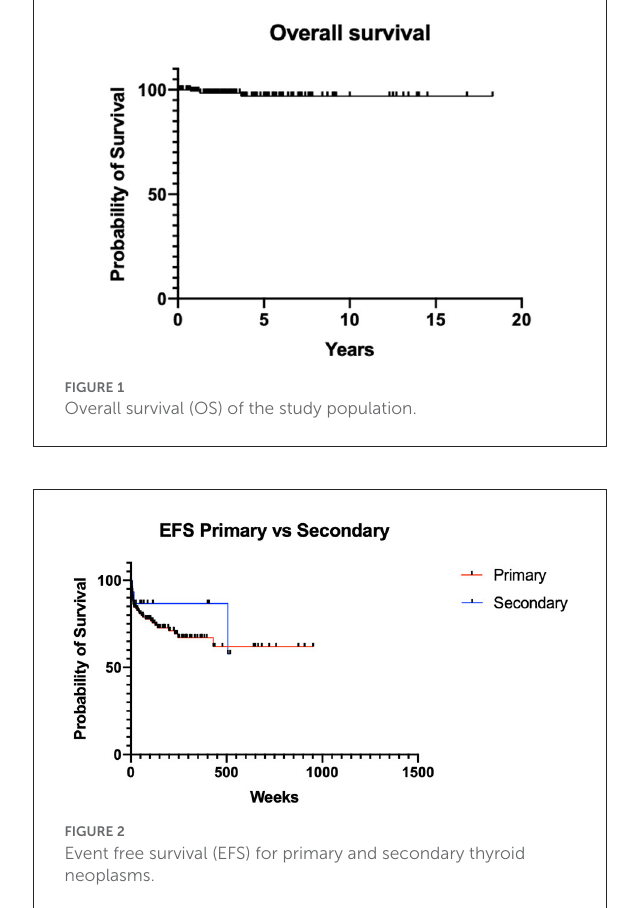
disease characteristics resulting from ionization in